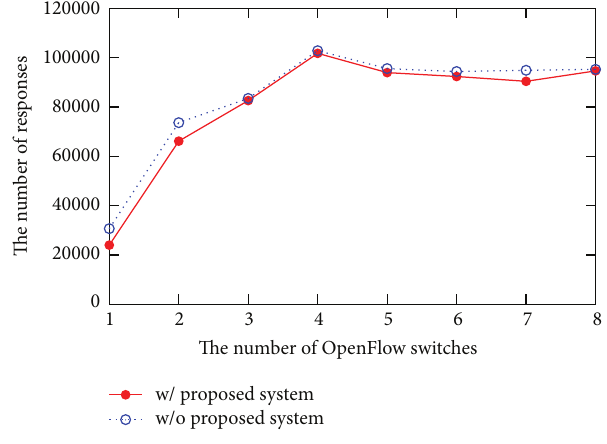
Figure 11: Evaluation on